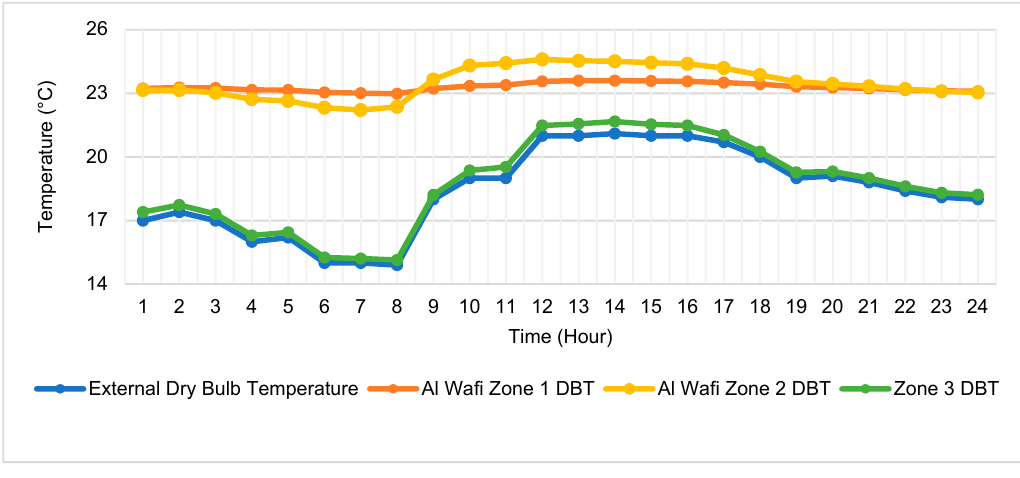
Figure 14. External DBT vs. Al Wafi DBT in winter by the hour during day 20.